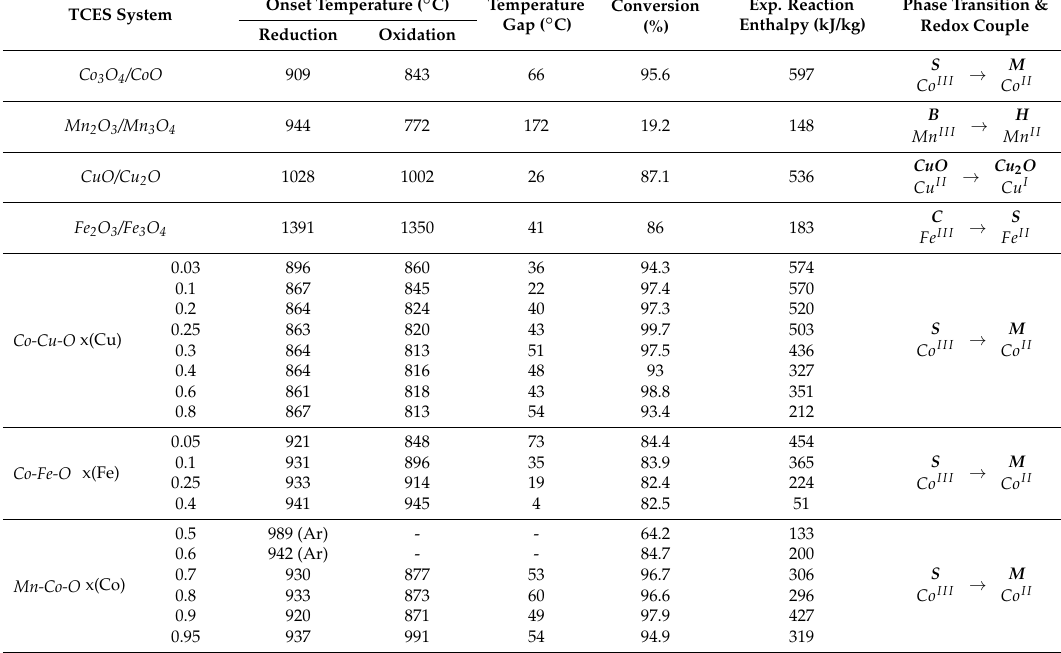
Table 1. Experimental data obtained for the investigated oxide systems (with 20% O 2 in Ar), comprising onset temperatures, chemical conversions and reaction enthalpy (B = Bixbyite, C = Corundum, S = Spinel, H = Hausmannite, M = Monoxide, D =